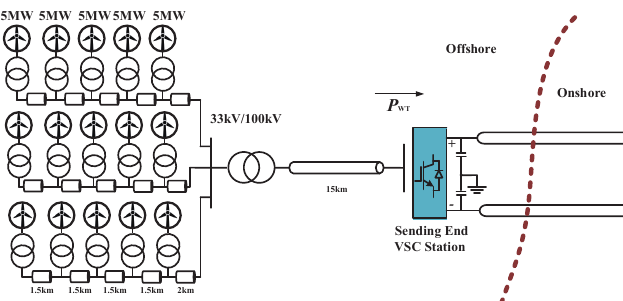
Figure 2. The configuration of the offshore wind farms that need to be